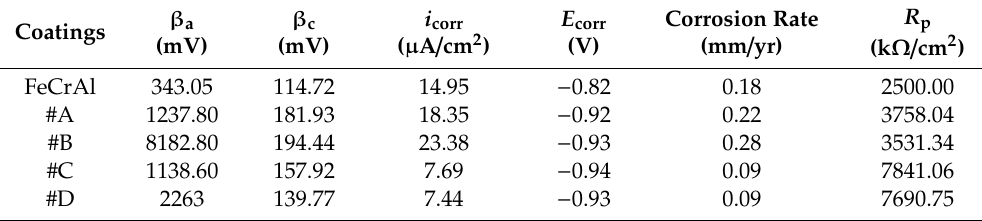
Table 4. Potentiodynamic polarization parameters of the sprayed